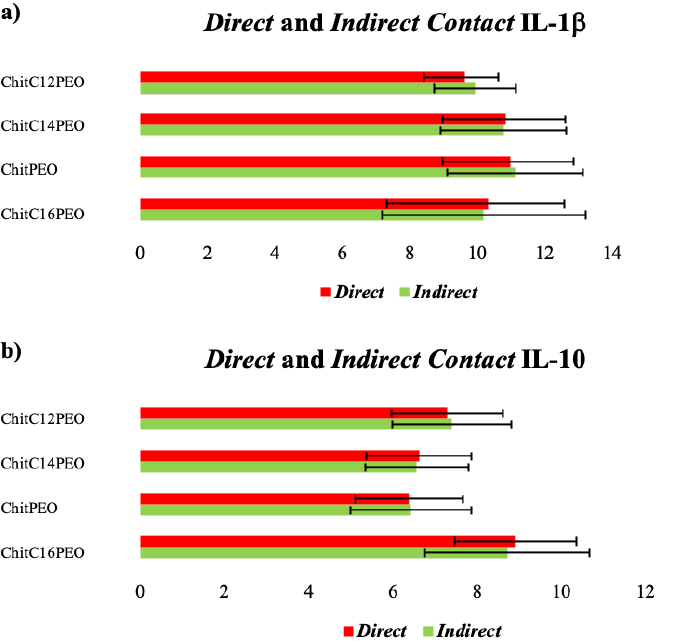
Figure 8. Direct and Indirect Contact IL- 1β ( a ) and IL-10 ( b ) levels. Results are expressed in pg/mL.